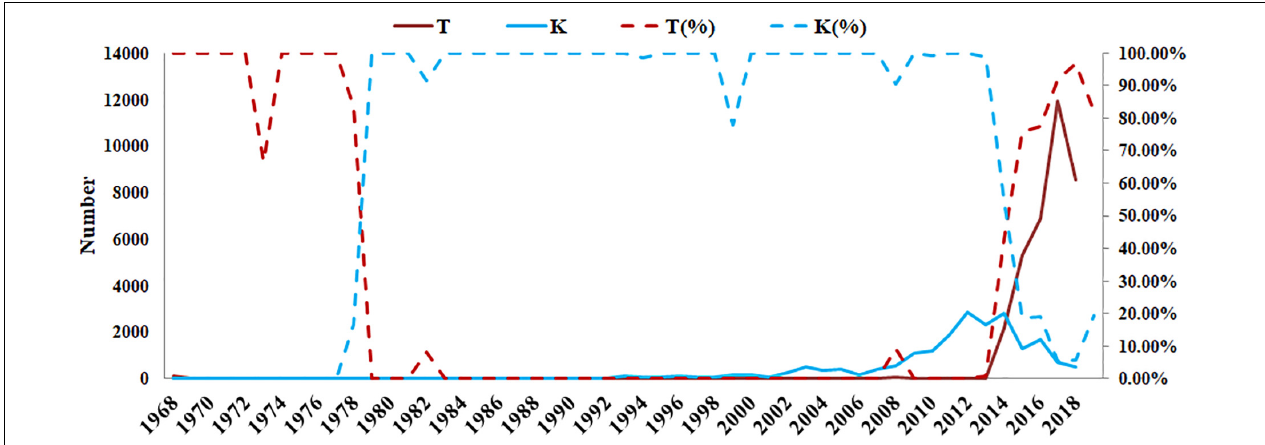
FIGURE 3 | Prevalence of T and K residues at HA1 position 160 in the world since 1968. The sequences of 62330 clinical strains worldwide from 1968 to 2019 were collected from GISAID. The T and K residues at HA1 position 160 were analyzed. The y-axis on the left: the number of HA1-160T and HA1-160K; The y-axis on the right: the percentage of HA1-160T and HA1-160K.